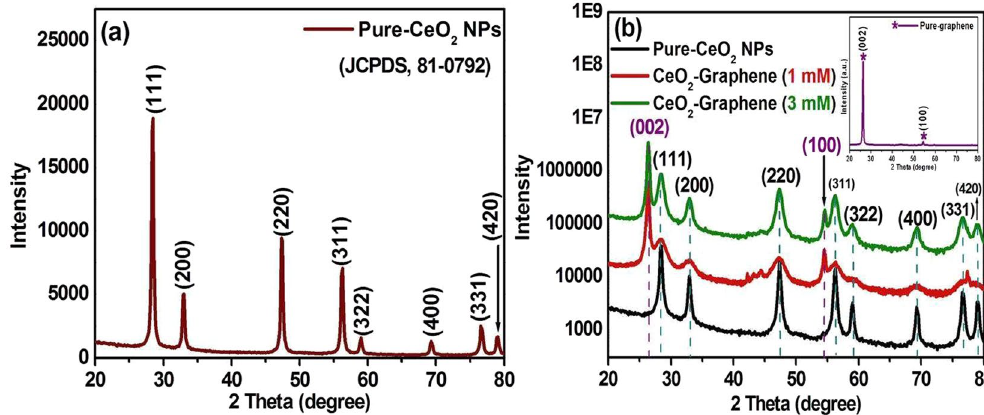
Figure 1. XRD patterns of bare ( a ) CeO 2 NPs, and, ( b ) CeO 2 -Graphene nanostructure, and inset shows the pure-graphene